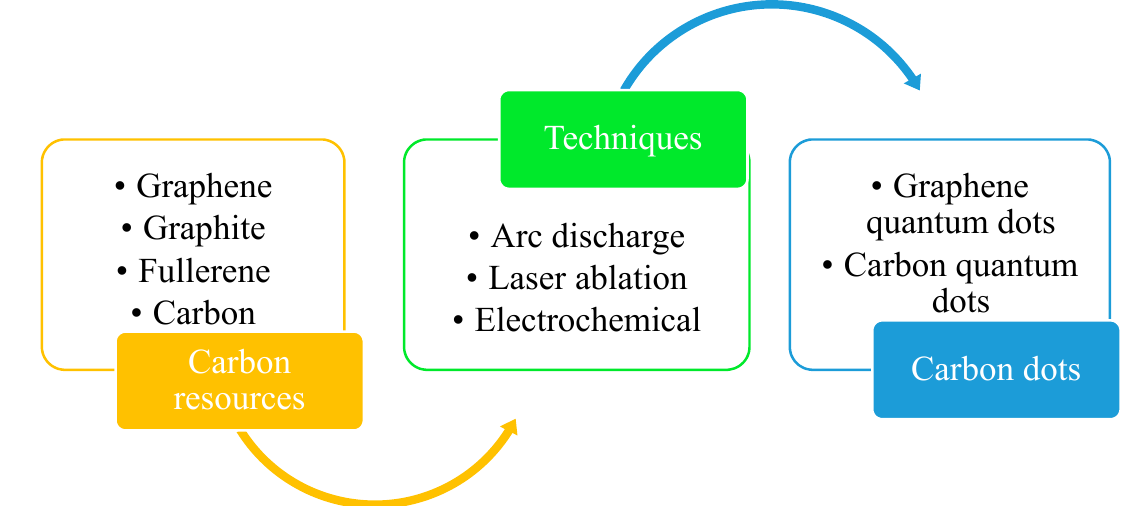
Figure 2. Top-down approach for the synthesis of carbon dots.